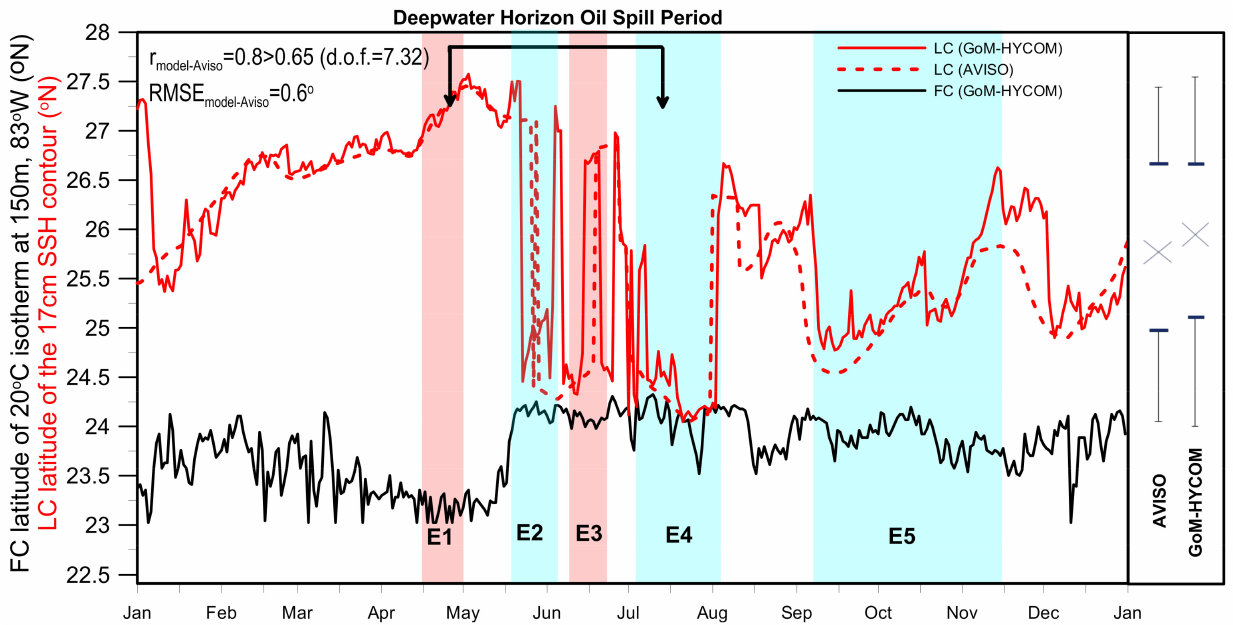
Figure 3. Daily evolution of the latitudes ( o N) of the Florida Current (FC) (position of the 20 o C isotherm at 150 m along 83 o W longitude; black line) and of the Loop Current (LC; from the 17-cm sea surface height (SSH) anomaly contour) for 2010 as derived from the GoM-HYCOM 1/50 model simulation (red solid line) and AVISO satellite data (red dashed line). Five CubAN periods are marked with shaded boxes: type “B” CubANs with extended LC (red shaded boxes) and type “A” CubANs with retracted LC (cyan shaded boxes). The Deepwater Horizon (DwH) oil spill period (black line at the top) is also marked. The RMSE and the Pearson correlation values with the respective degrees of freedom (d.o.f.) between simulated and satellite-observed LC latitude for 2010 are given (top left). The satellite (left) and simulated (right) annual box plots (minimum, maximum, 1st quartile, 3rd quartile and median) of the LC maximum latitude in 2010 are also